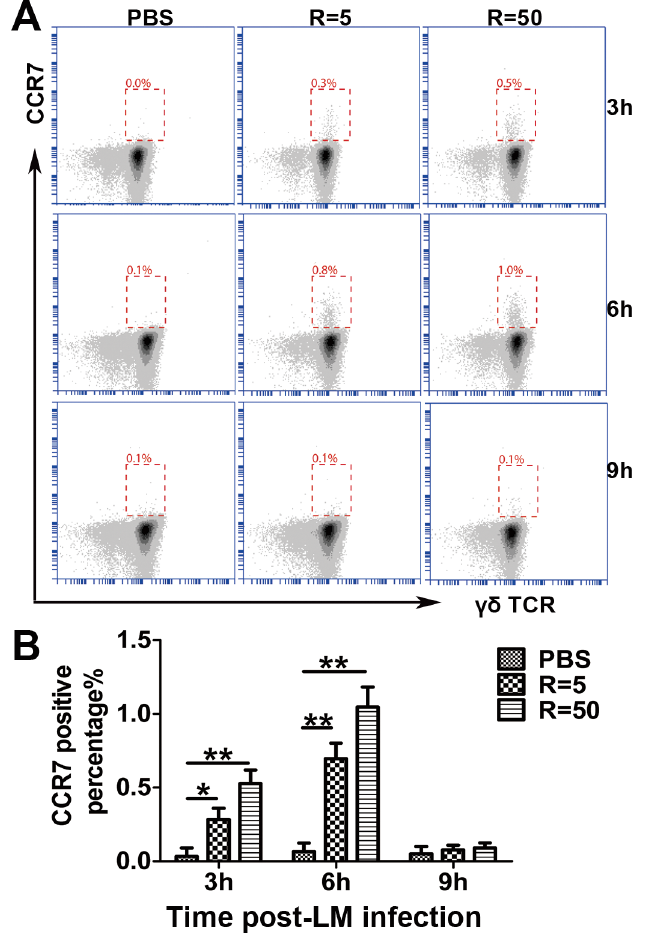
Figure 4. FCM analysis of CCR7 on activated γδ T cells after phagocytosed L. monocytogenes . The expression of CCR7 on activated γδ T cells was upregulated in a bacteria dose dependent manner three hours after L. monocytogene infection. The peak of CCR7 ex- pression was at six hours and gradually decreased at nine hours. Normalized mean fluores- cence intensity (MFI) values are shown as mean ± SEM (independent experiment of n = 5). * P <